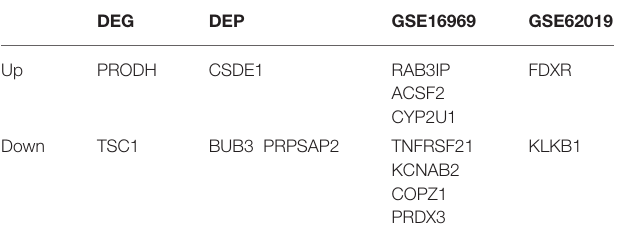
TABLE 4 | Differentially expressed proteins that overlap with the databases. DEG